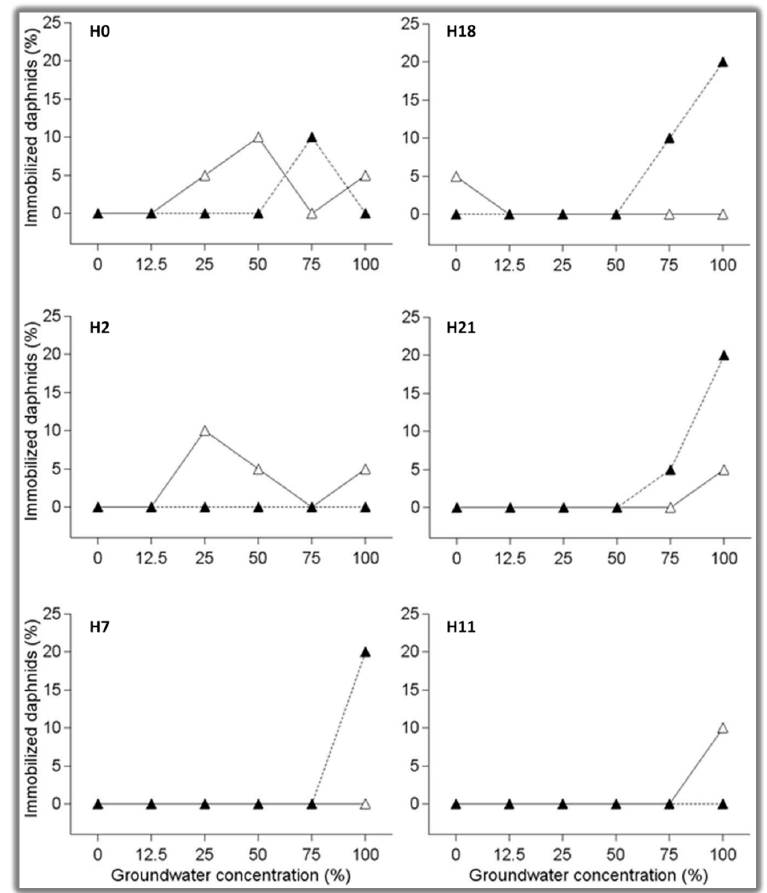
Figure 9. Groundwater ecotoxicology from Paranhos and Salgueiros spring galleries. Immobilization of D. magna juveniles following exposure in 96 h standard acute bioassays to groundwater samples collected in 2006 (white triangles) and 2007 (black triangles).